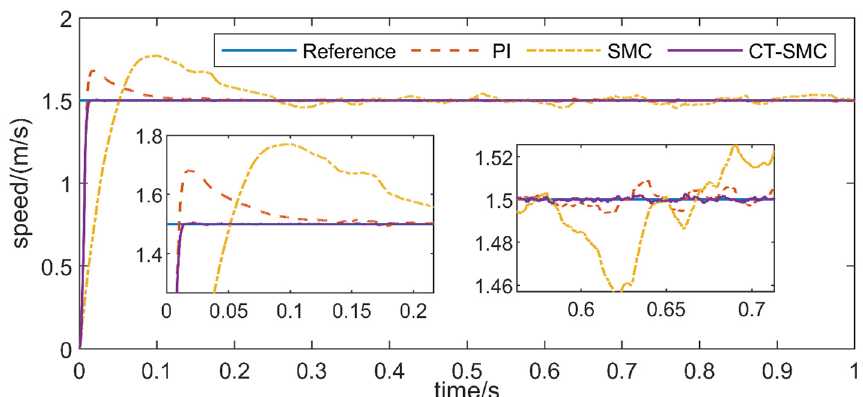
Figure 6. Random load added to the system.